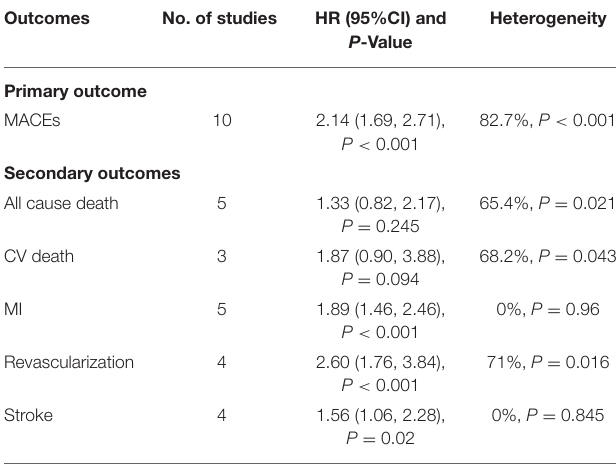
TABLE 2 | Association between the Triglyceride-glucose (TyG) index and cardiovascular events.